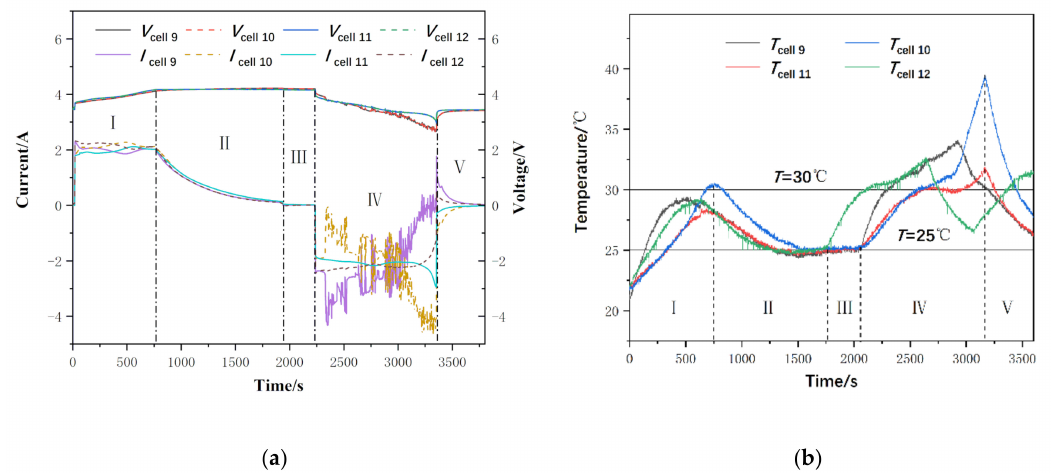
Figure 6. Pack D during the 95th charge–discharge profile: ( a ) current and voltage; ( b )